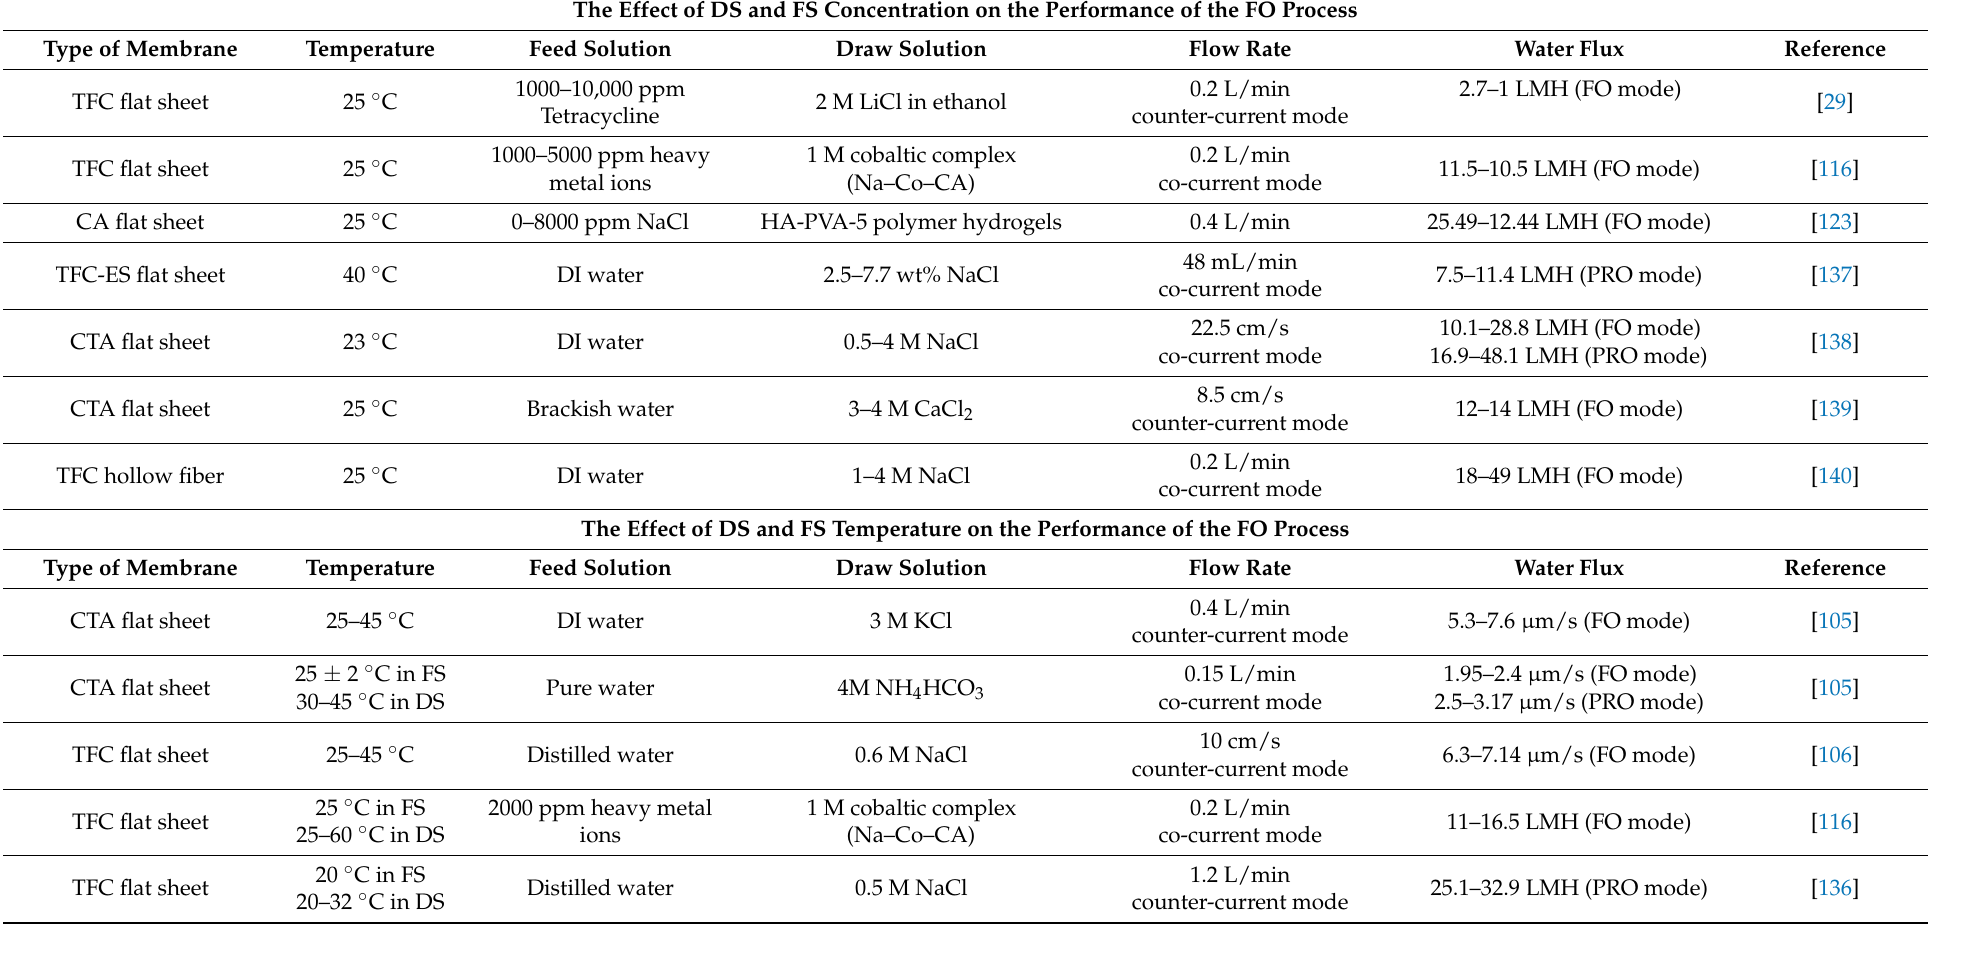
Table 3. Cont. The Effect of DS and FS Concentration on the Performance of the FO